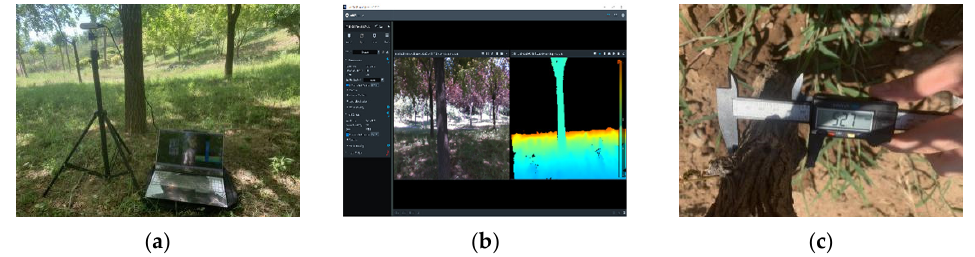
Figure 2. Trunk information collection. ( a ) Information acquisition equipment, ( b ) Information acquisition interface, ( c ) Digital display vernier caliper measurement.